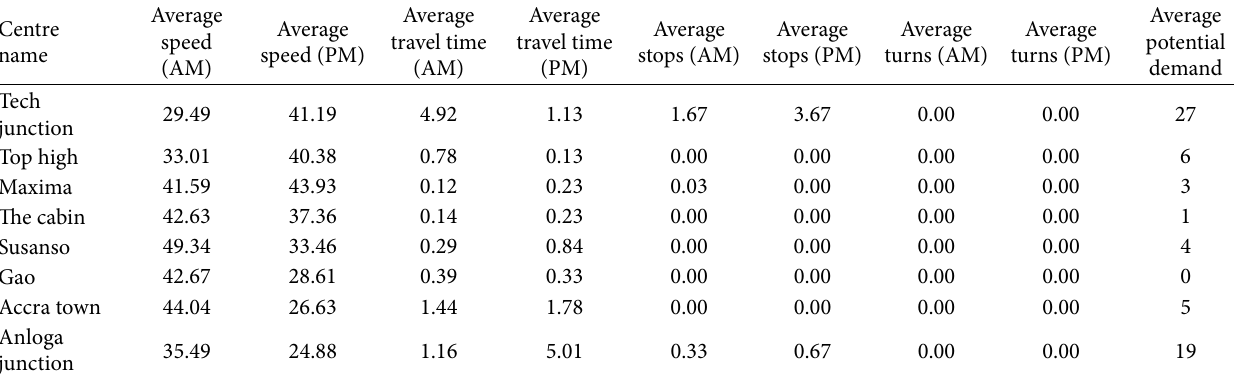
Table 3: Travel survey data for public shuttles on mondays in all the